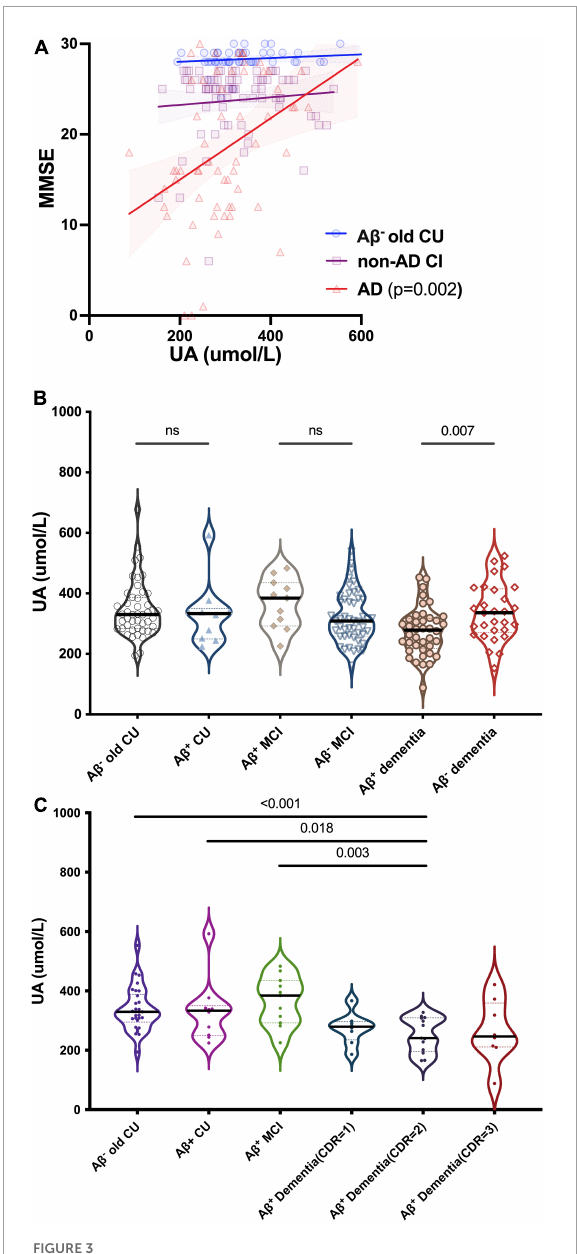
FIGURE3 Relationships between UA and cognition in CU and different types of CI. (A) Spearman’s correlation analysis between the levels of sUA and MMSE scores in old CU, non-AD CI and AD. (B) Kruskal–Wallis test for the levels of sUA between cognitive subgroups. (C) Dynamic changes of sUA along for the process of AD. The p value, two-tailed Spearman’s correlation (A) or Mann–Whitney U test (B,C) . ns, not